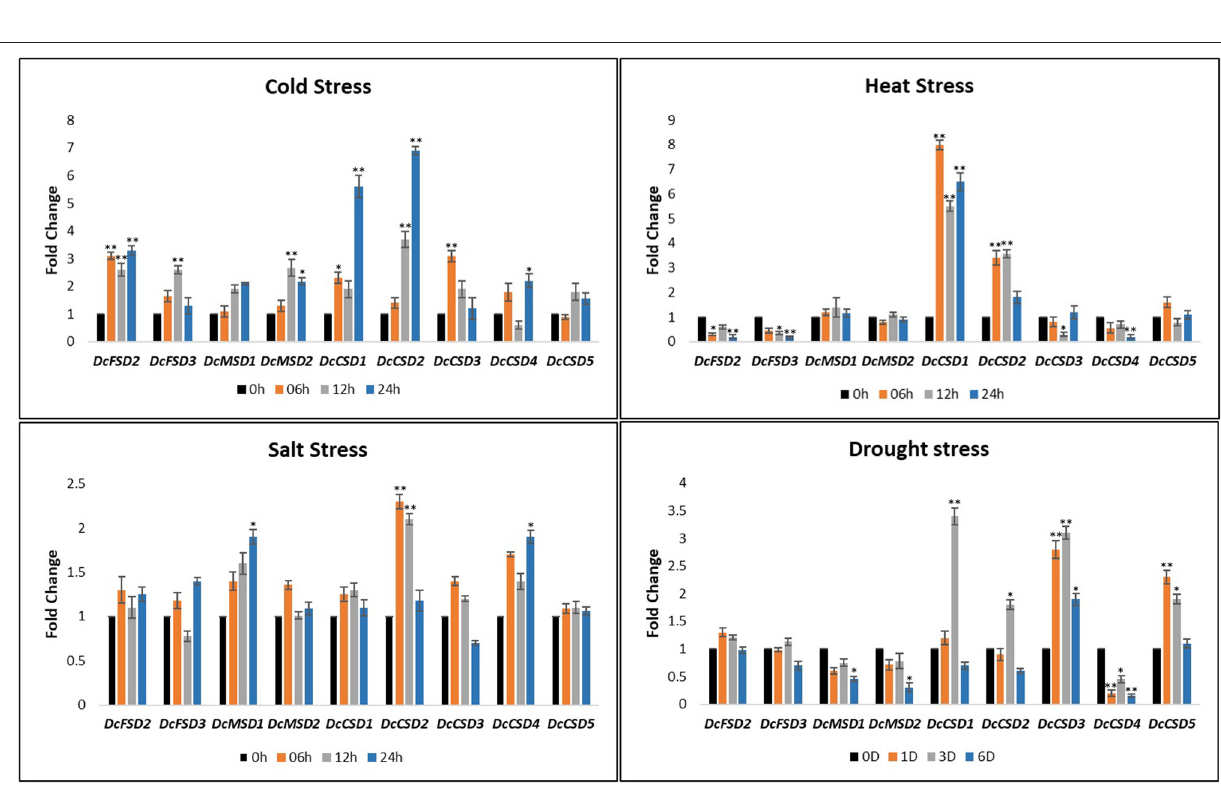
Frontiers in Plant Science |